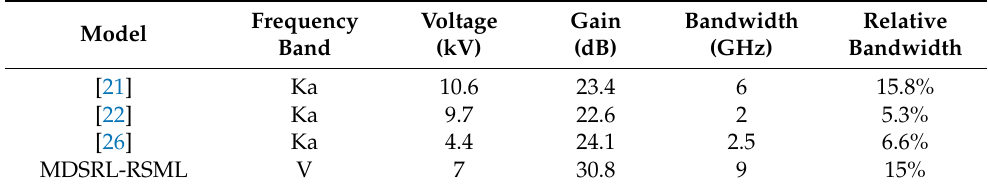
Table 5. Performance comparison of dielectric-supported meander-line SWSs. Model